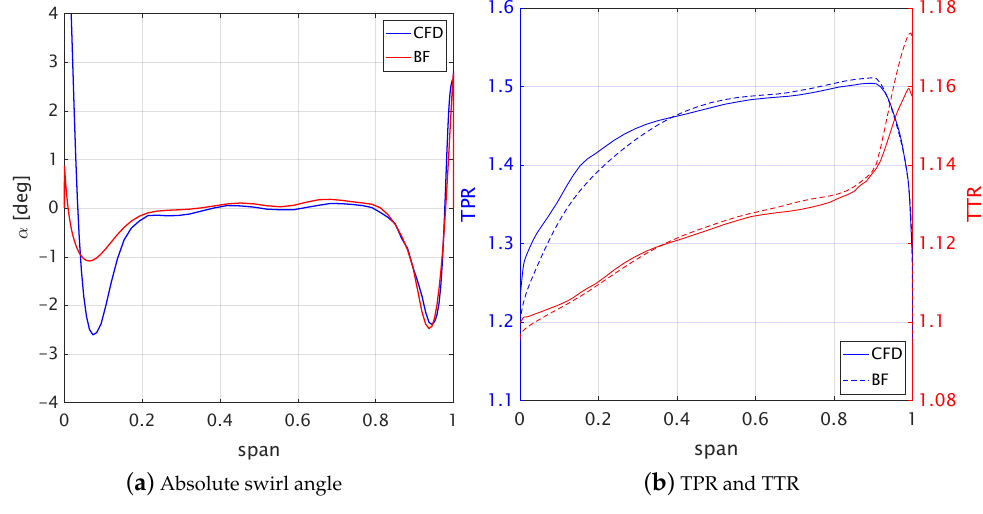
Figure 20. Outflow radial profiles for fan+OGV stage. Table 4. Integral performance indexes of fan+OGV stage for CFD and BFM